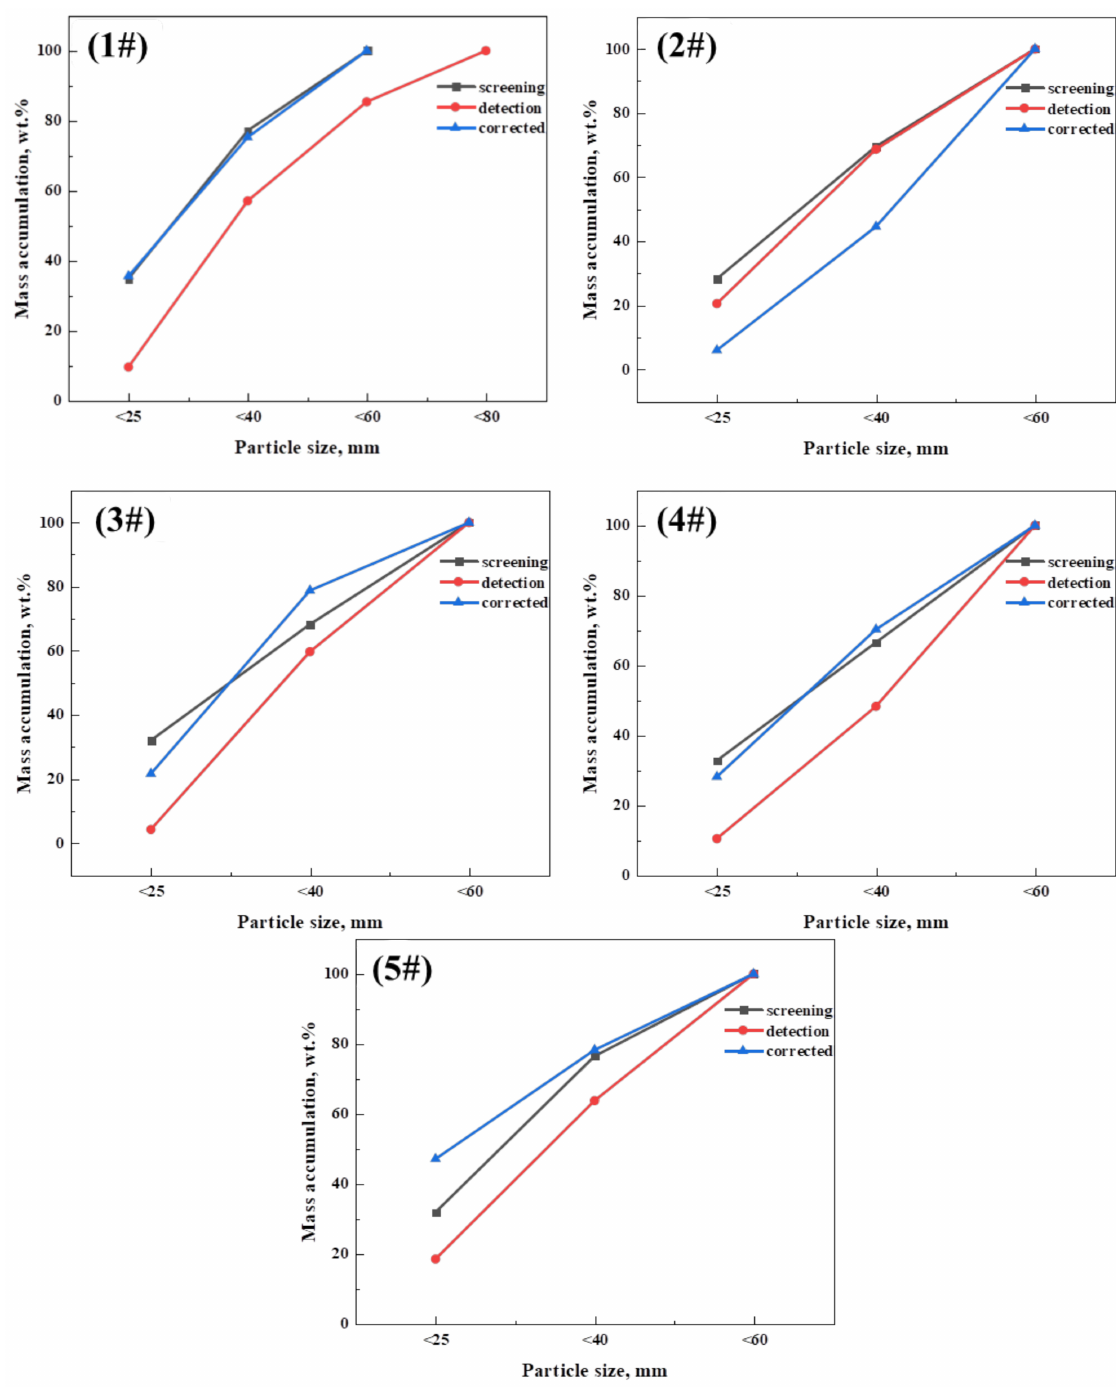
Figure 16. Comparison of particle size for five groups of experimental